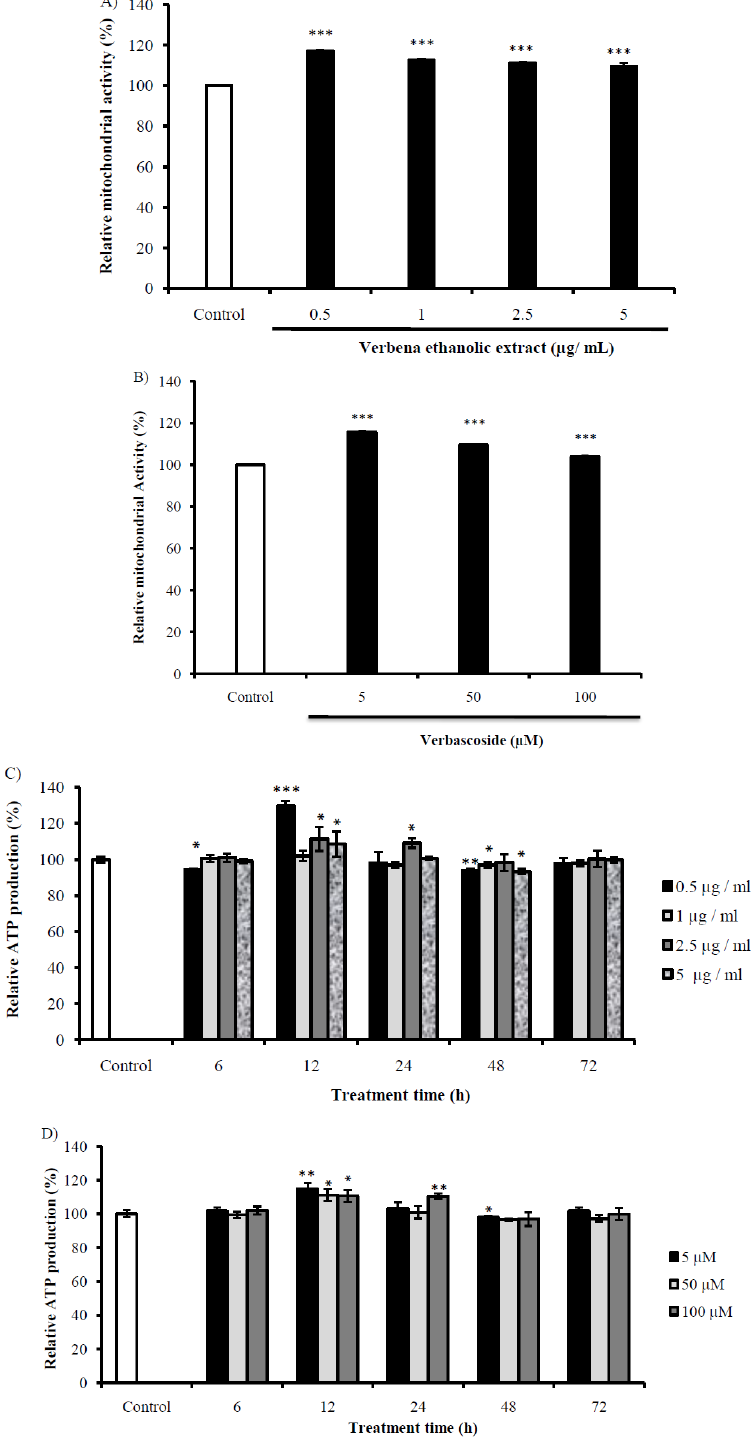
Figure 5. Evaluation of mitochondrial activity of SH-SY5Y cells treated with different concentrations of ( A ) VEE and ( B ) Vs. The intracellular ATP production of SH-SY5Y was assessed in vitro using the same concentrations of ( C ) VEE and ( D ) Vs at 6, 12, 24, 48 and 72 h. Results were expressed in mean of relative mitochondrial activity or ATP production (%) ± SD. * P < 0.05; ** P < 0.001; *** P < 0.0001 compared with control cells treated with